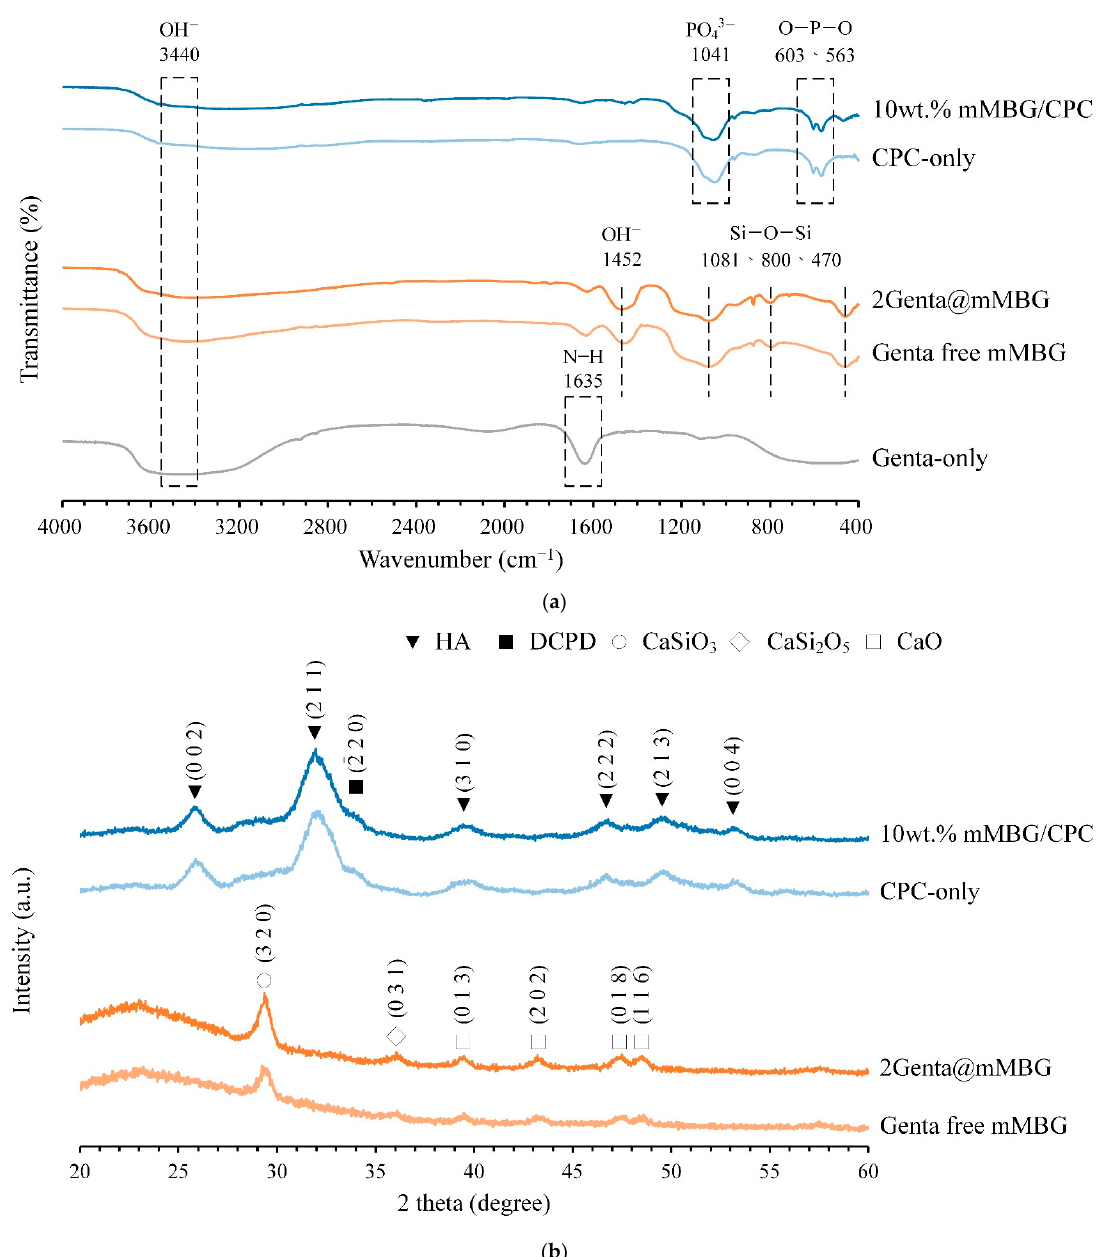
Figure 6. ( a ) FTIR and ( b ) XRD analysis of mMBG before (Genta-free) and after impregnation with Genta (2Genta@mMBG), and the CPC-only and 10 wt.% mMBG/CPC composite bone cement after 24 h immersed reaction.